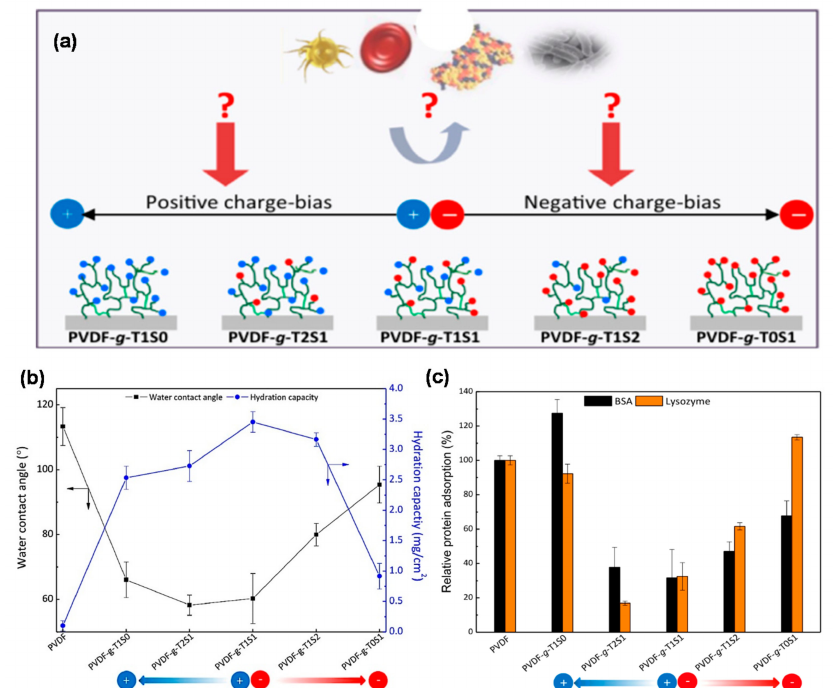
Figure 8. ( a ) Scheme of polyvinylidene Fluoride (PVDF) membranes coated with [2-(methacryloyloxy) ethyl] trimethylammonium (TMA) and sulfopropyl methacrylate (SA) monomers, before